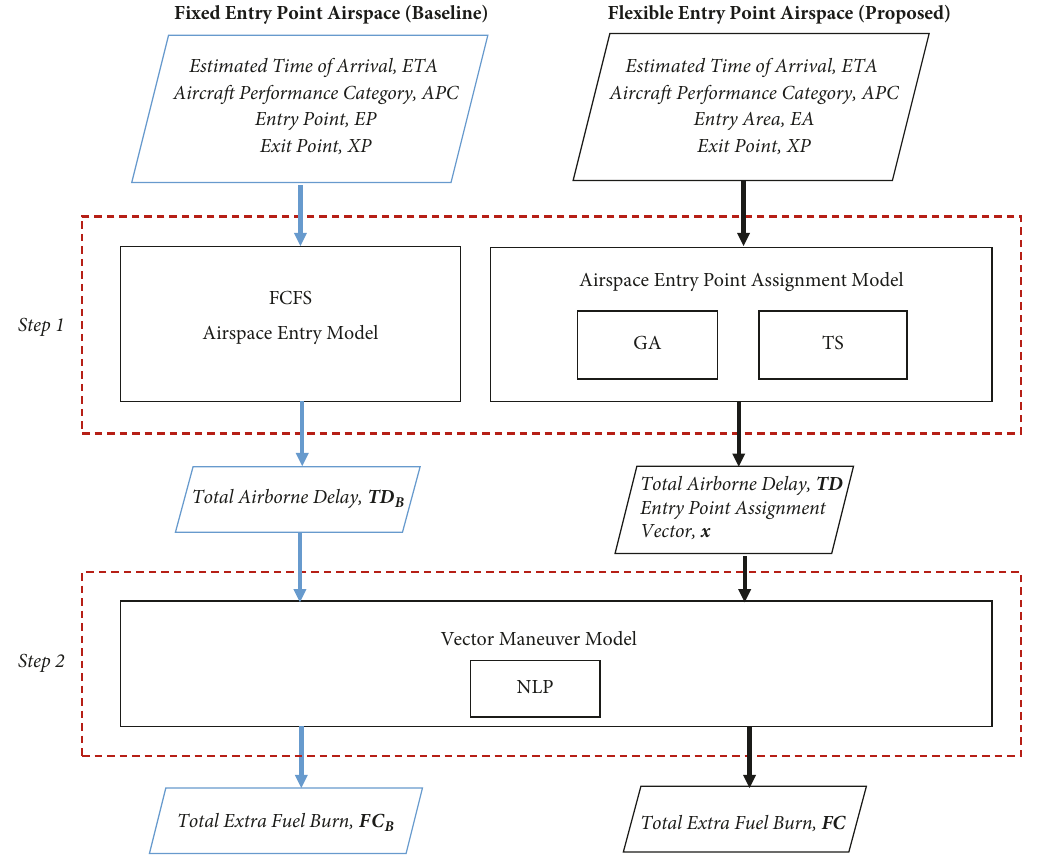
Figure 6: Flow diagram of the two-step